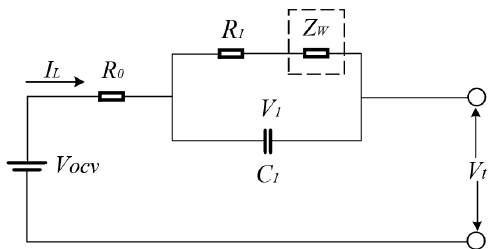
Figure 3. Electrochemical impedance spectrum equivalent circuit diagram.